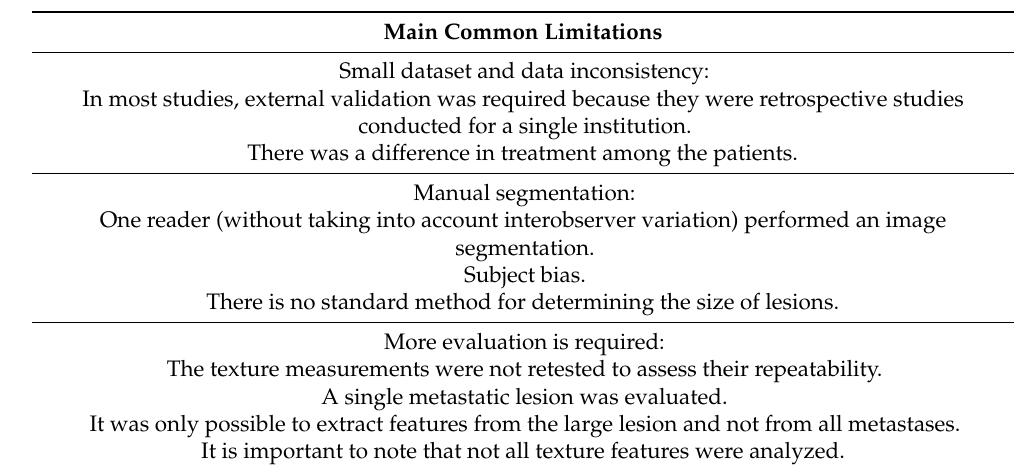
Table 3. Summary of limitations from the reviewed